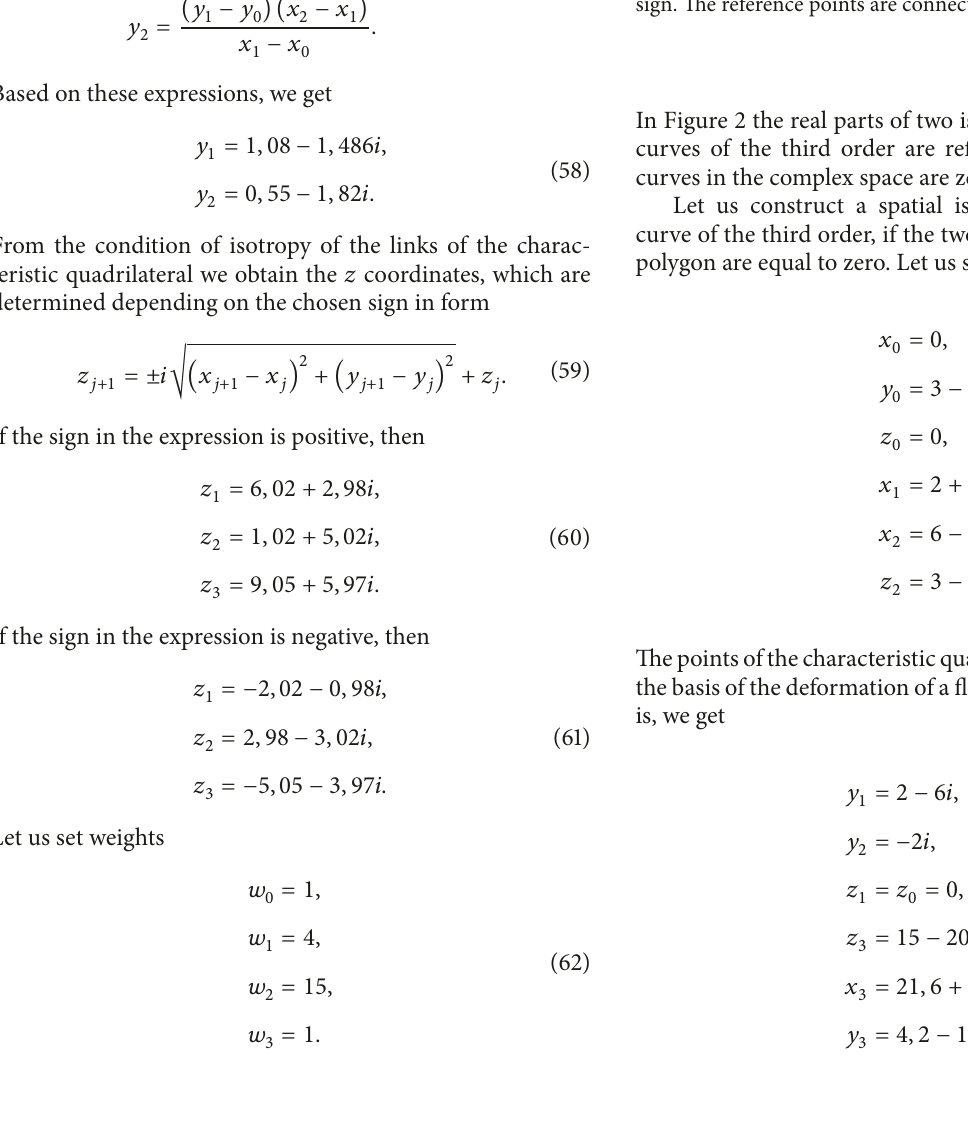
Figure 2: Real parts of cubic isotropic fractional-rational curves constructed on the basis of a flat curve deformation. Solid bold line corresponds to positive sign and dotted-dashed bold line to negative sign. The reference points are connected by broken thin